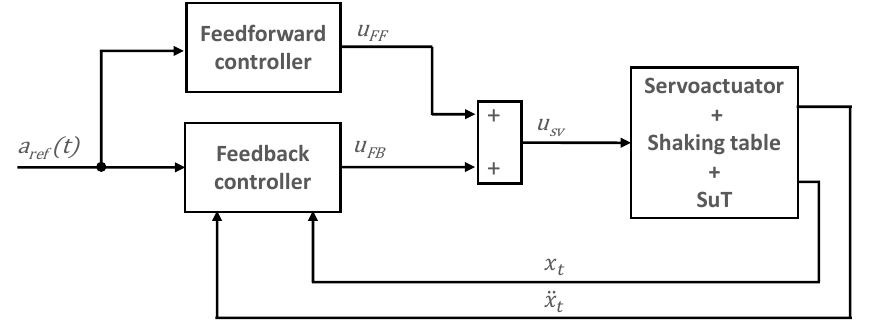
Figure 1. Generic time domain control architecture for shake table.